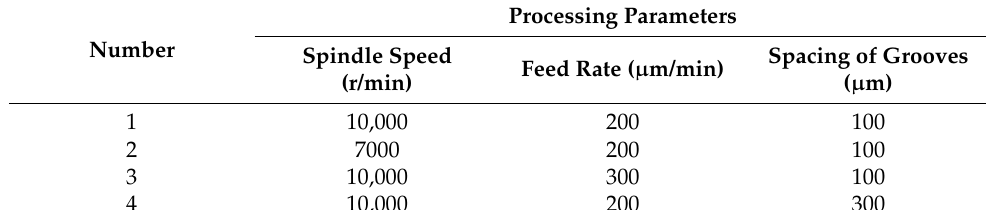
Table 3. Machining parameters of microgrooves.